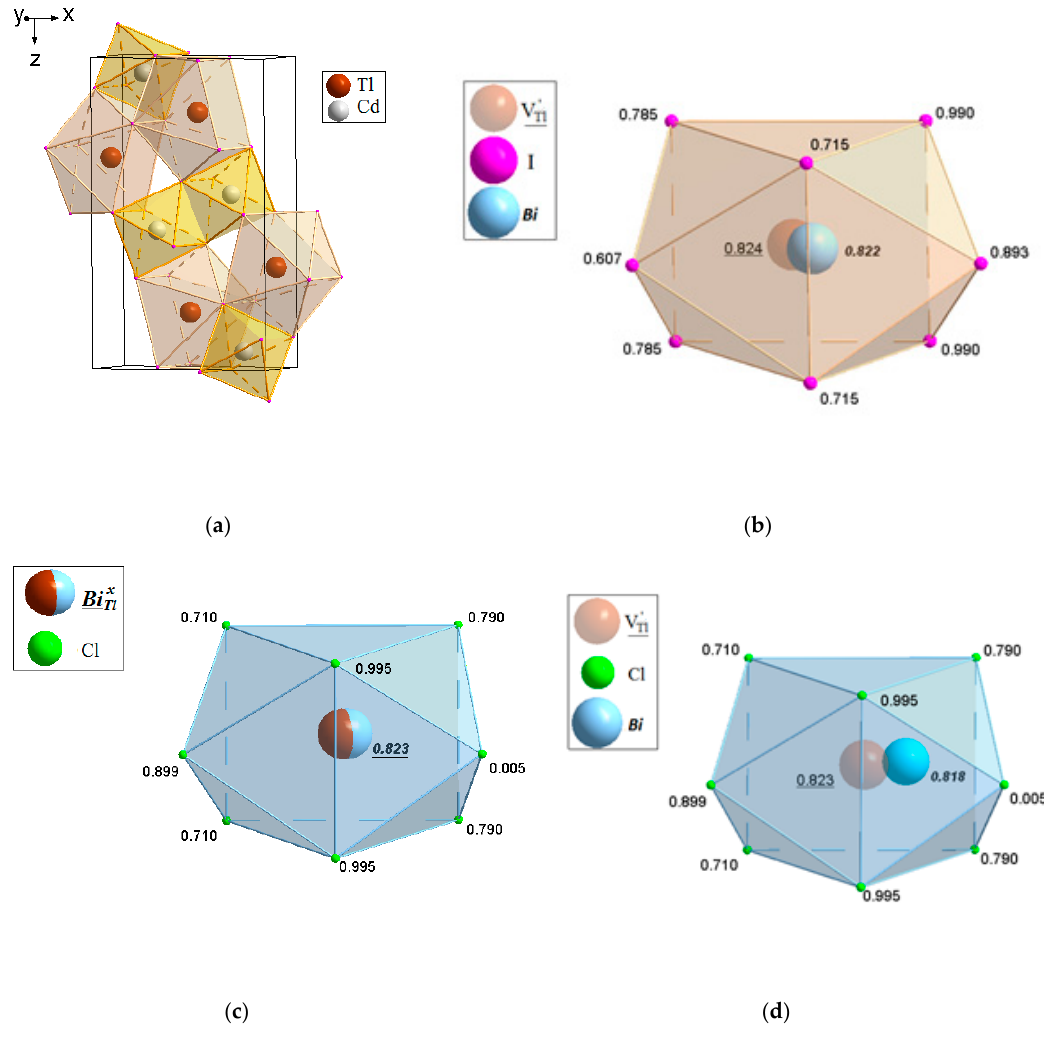
Figure 16. ( a ) Structure of TlCd X 3 ( X = Cl, I); ( b ) The (Tl,Bi i )I 8 , ( c ) (Tl,Bi)Cl 8 , ( d ) (Tl,Bi i )Cl 8 coordination polyhedra.